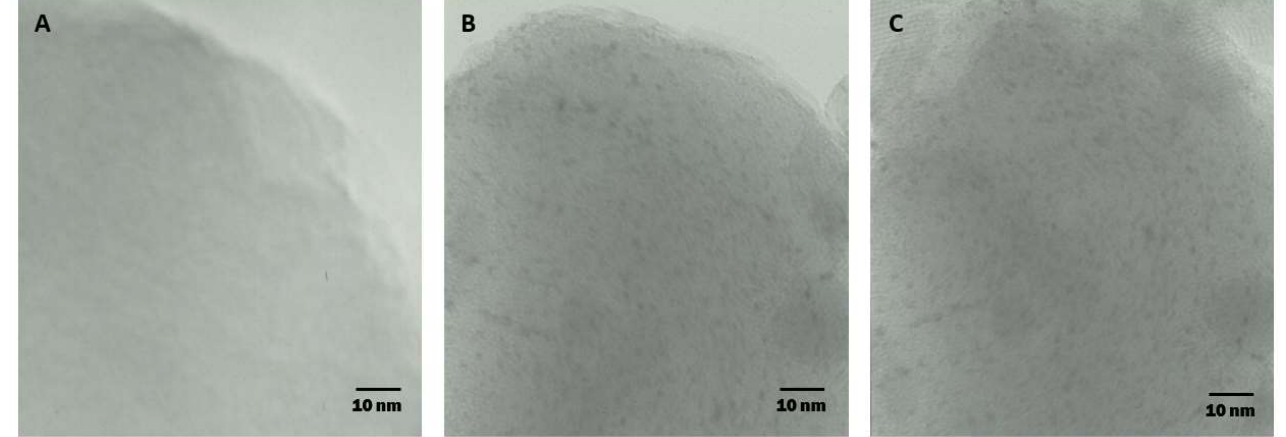
Figure 6. TEM images of Pd-PW-HAP before reaction and after reaction. ( A ): Before reaction; ( B ): after reaction at 363 K for 8 h; ( C ): after reaction at 363 K for 8 h for 5 runs.